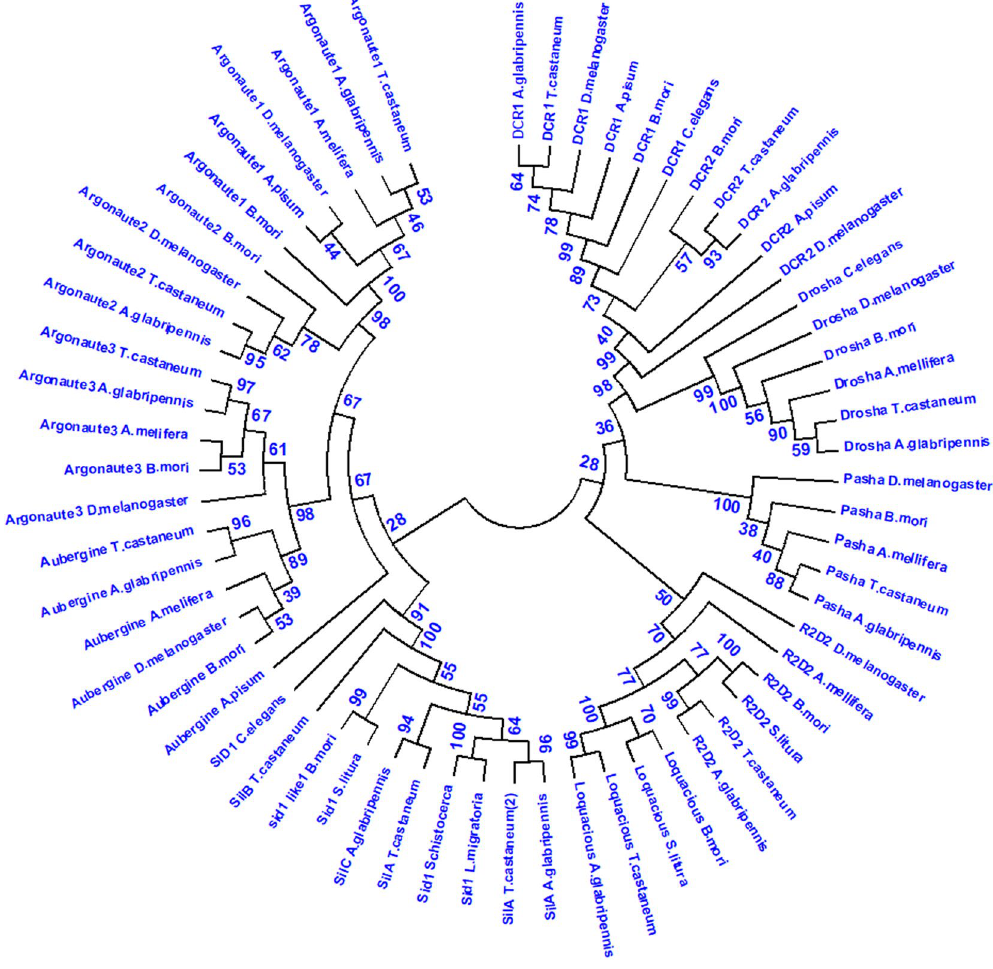
Figure 1. Phylogenetic tree of RNAi genes. The software MEGA 7.0 was used to construct the phylogenetic tree. Neighbor-joining method was performed and bootstrapping was used to estimate the reliability of phylogenetic reconstruction (5000